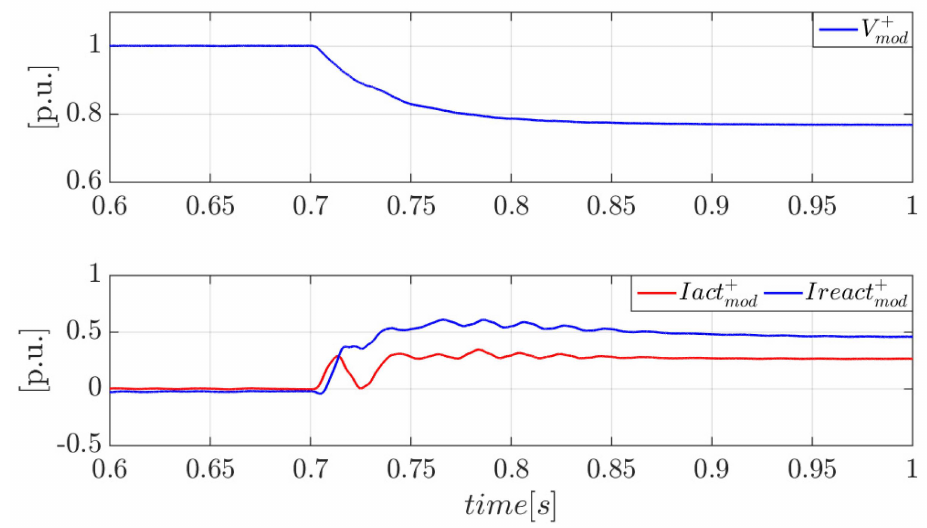
Figure 20. GFM converter positive sequence voltage and currents during an unbalanced fault with 0.23 p.u. depth.